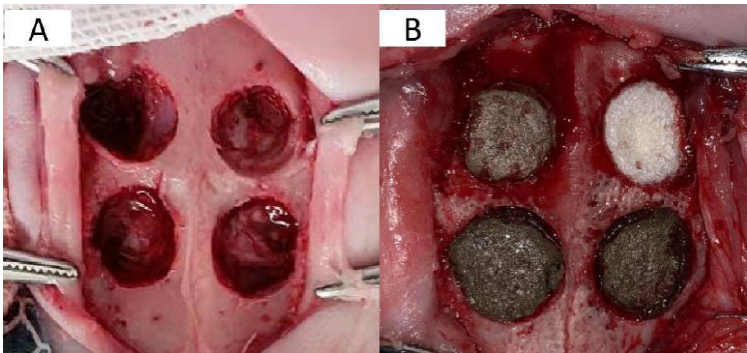
Figure 1. Rabbit skull defect preparation and material implantation: ( A ). reparation of rabbit skull defect models; ( B ). the implantation of AgNP–Gel/Alg stents with different scaffolds.